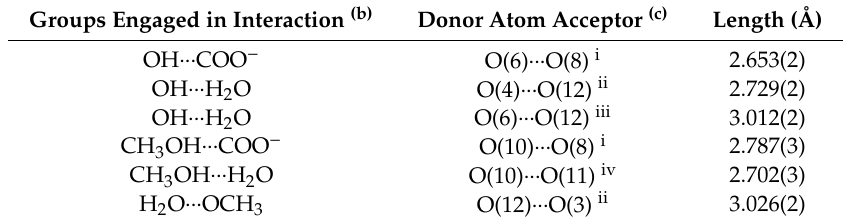
Table 3. Hydrogen-bonding interactions in [Zn(CH 3 COO)(cur)(bpy)]( 1 ) · CH 3 OH · 2H 2 O (a) . Groups Engaged in Interaction